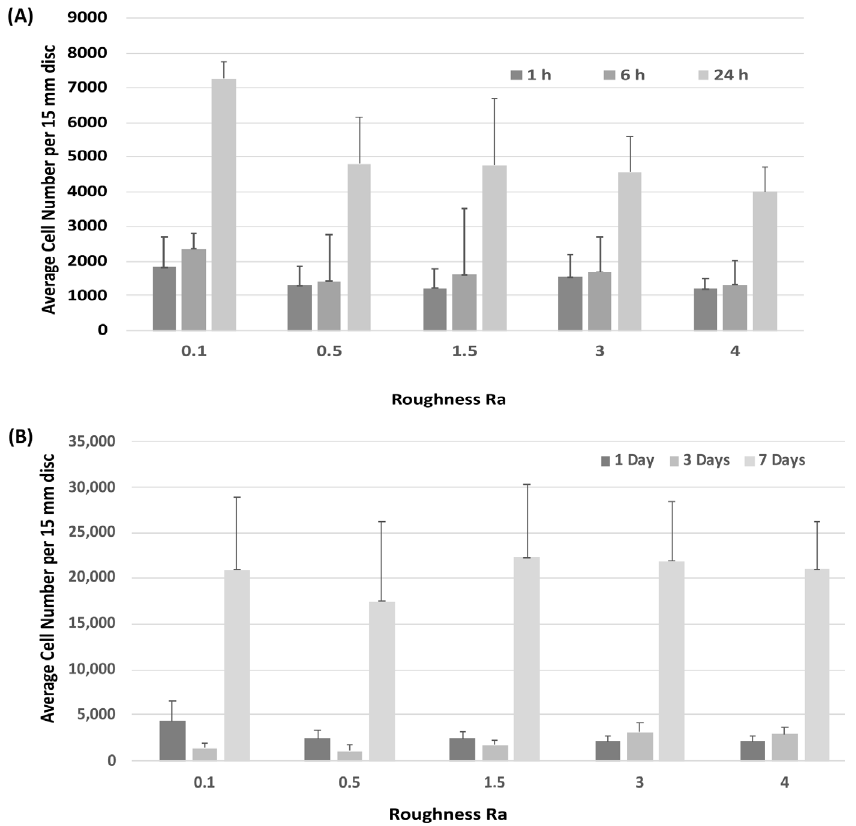
Figure 2. Influence of titanium substratum roughness on cell adhesion and temporal increase in cell number. Cells were seeded on each type of topography for ( A ) 1, 6 and 24 h to assess attachment, and ( B ) 1, 3 and 7 days to assess increase in cell number. No differences in initial attachment or cell proliferation of HGFs on the topographies were quantified. One-way ANOVA followed by a Bonferroni